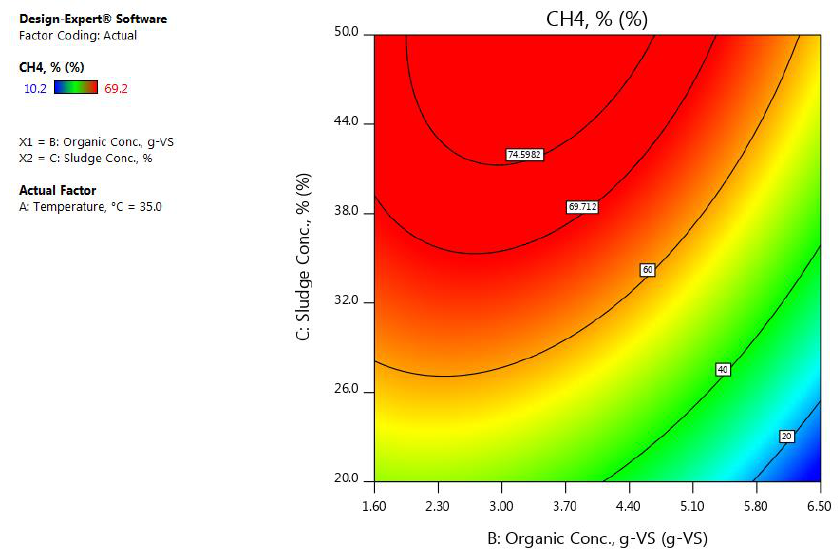
Figure 9. The interaction of the BC on the CH 4 % in contour plot.